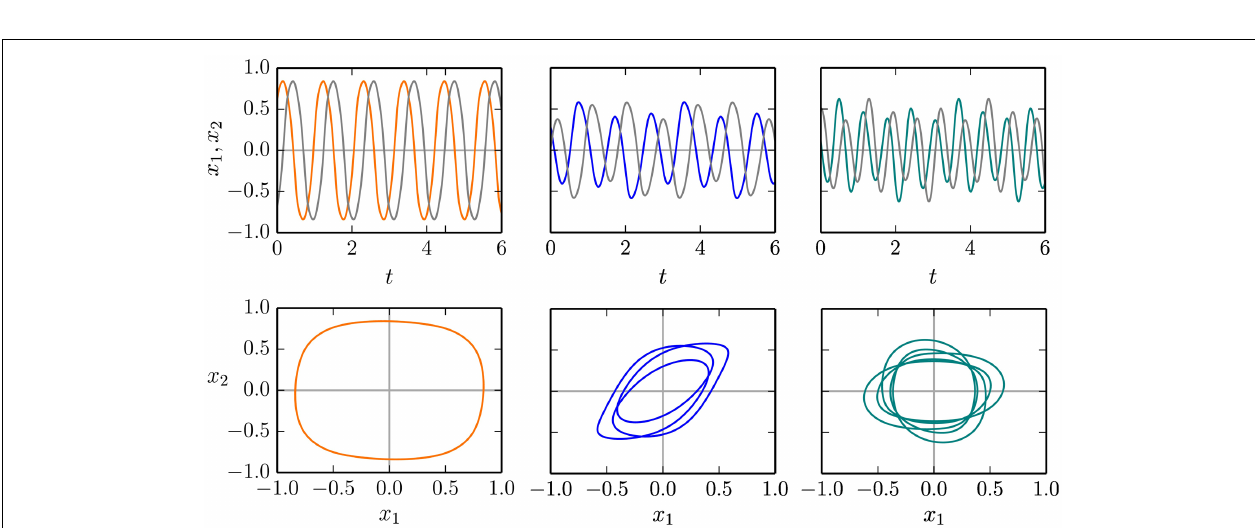
FIGURE 9 | Time series x 1 ( t ) and x 2 ( t ) of the balls along the two rods of the two-rod barrel (top row), and the respective phase plots ( x 1 ( t ), x 2 ( t )) . Shown are the 1:1/1:3/1:5 modes (left/middle/right column) for ε = 1.0/0.5/1.5, compare Figure 8 , needing, respectively, 1/3/5 revolutions around the origin ( x 1 , x 2 ) = (0,0) in order to close. For the corresponding videos, see the Supplementary Material.